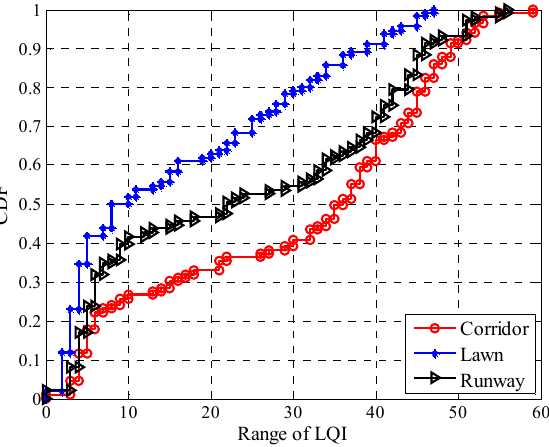
Figure 20. CDFs of the fluctuation range of LQI in different environments.